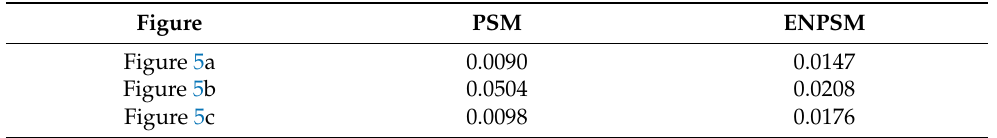
Table 6. RE results delivered by five unmixing method over Figure 5a–c by means of maximum volume simplex analysis (MVSA) extraction algorithm